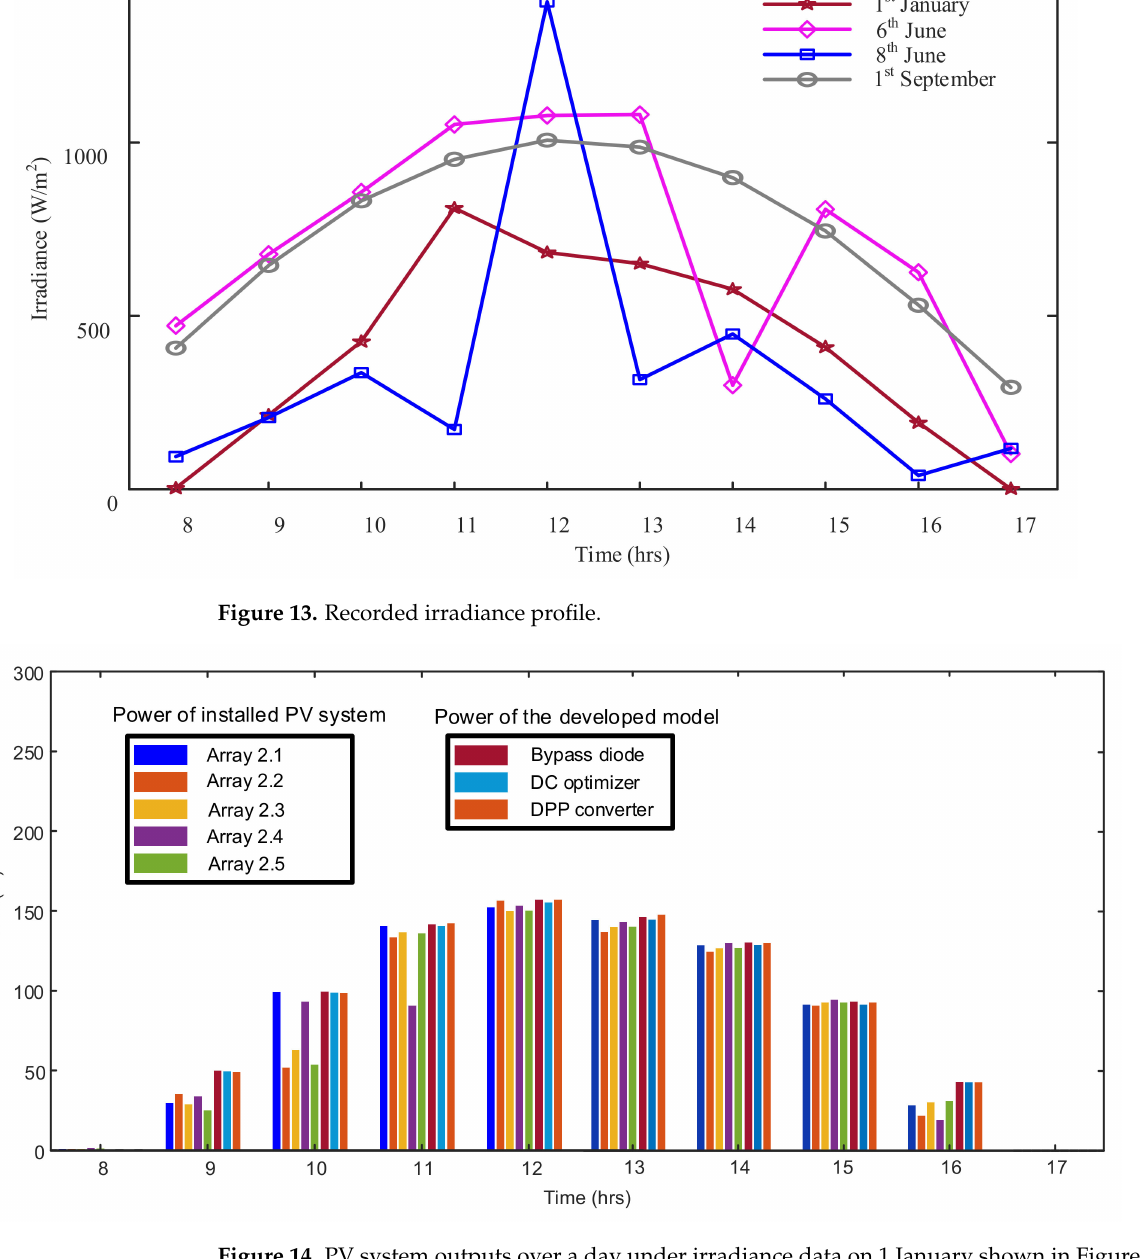
Figure 14. PV system outputs over a day under irradiance data on 1 January shown in Figure